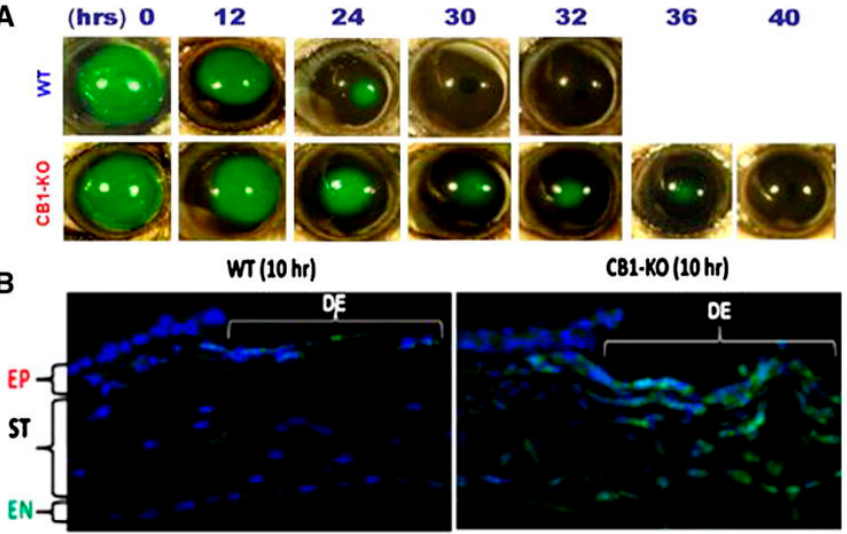
Figure 3. CB1 activation promoted mouse corneal reepithelialization. ( A ) Time-dependent epithelial wound healing was evaluated following epithelial debridement with an Algerbrush in control (WT) and CB1 − / − mice. The wound area was identified based on the extent of fluorescein staining. Corneal